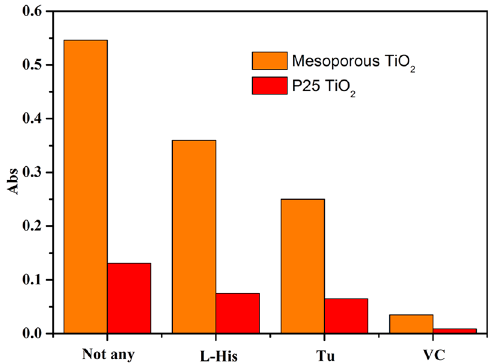
Figure 6. Absorbance of DPCO in DPCI solution in the presence of mesoporous spherical TiO 2 and P25 TiO 2 under UV-light irradiation with various quenching reagents. ([DPCI] = 1.00 × 10 − 3 mol/L, [mesoporous spherical TiO 2 ] = [P25 TiO 2 ] = 1.00 g/L, [L-His] = [VC] = [Tu] = 5.00 × 10 − 3 mol/L, T = 298 K and t = 60 min).